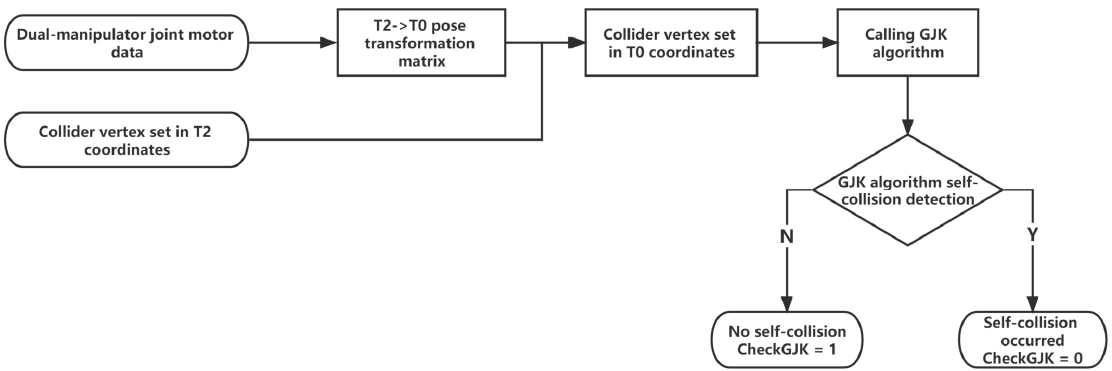
Figure 6. Flowchart of GJK algorithm self-collision detection.